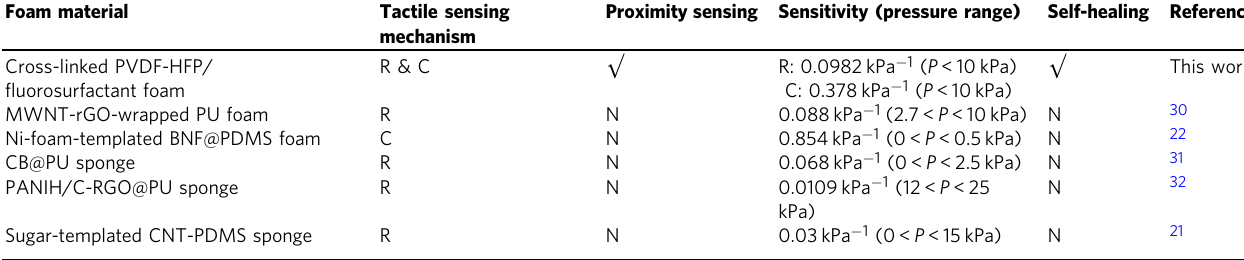
Table 2 Comparison of foam sensing